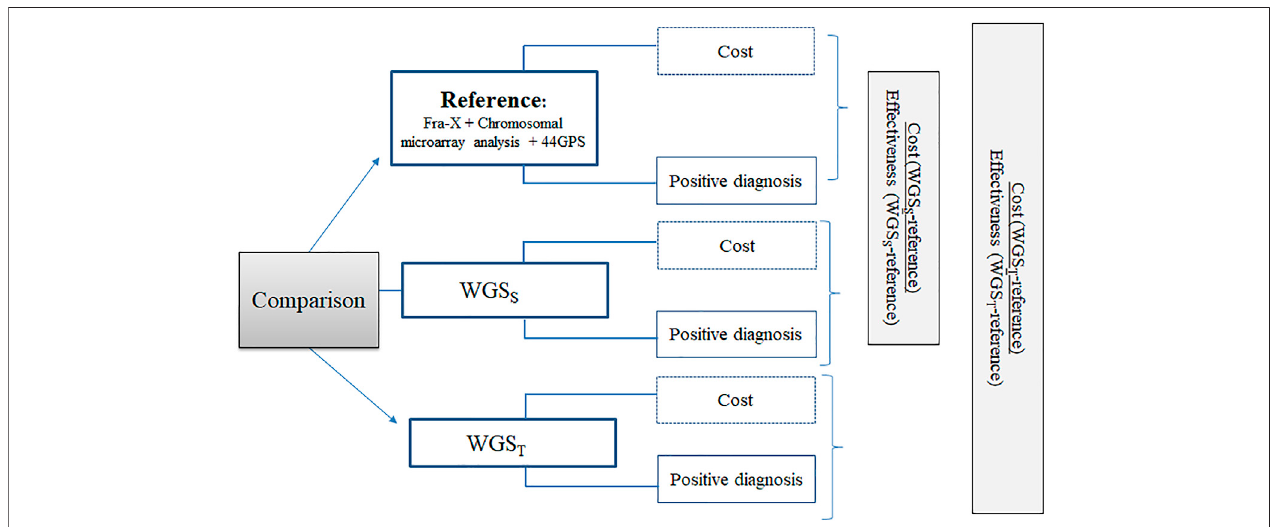
FIGURE 1 | Design of the ef fi ciency study: This fi gure illustrates the design of the cost-effectiveness study. Three strategies will be compared: the solo Whole Genome Sequencing strategy (WGS S ), the trio Whole Genome Sequencing strategy (WGS T ) and the reference strategy. Comparisons will be made simultaneously in terms of cost and effectiveness (positive